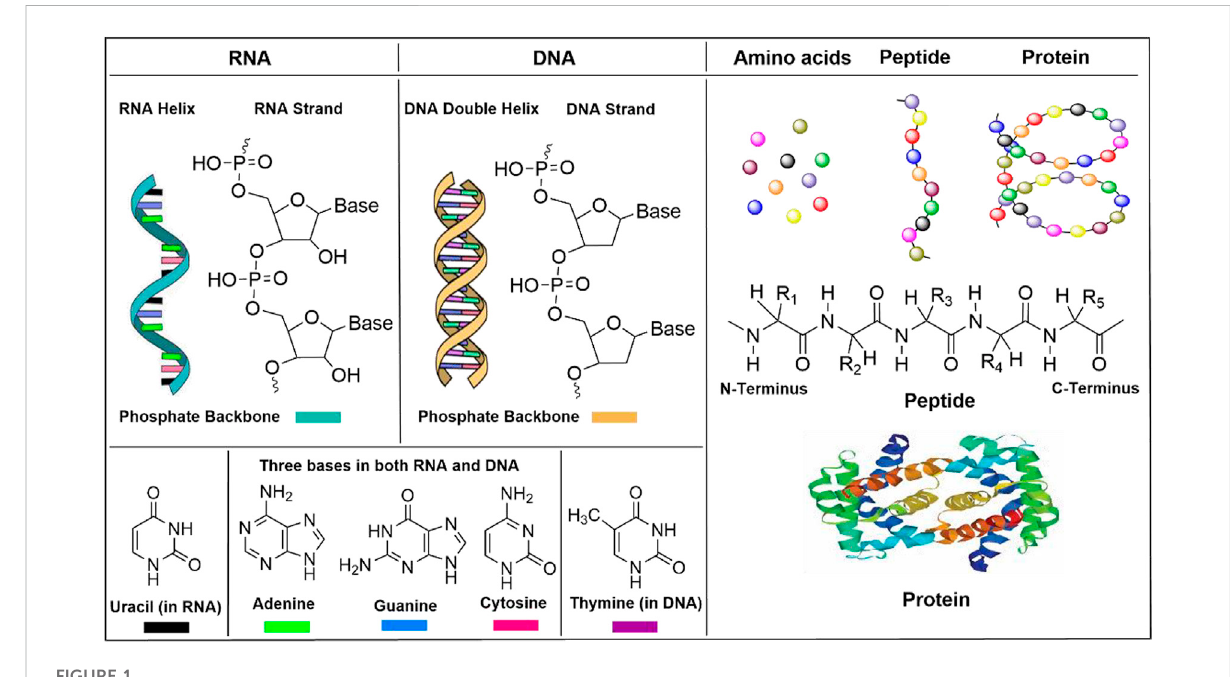
FIGURE 1 Chemistry of RNA, DNA, and protein- fundamentals of the property of